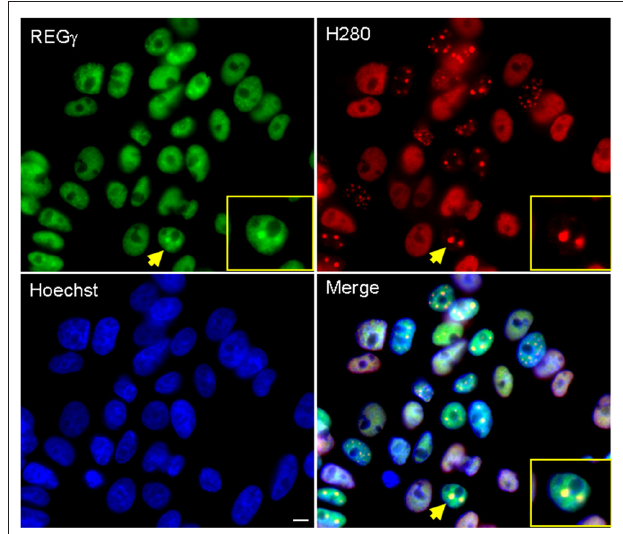
FIGURE 1 | REG γ colocalizes with ARQ112 in inclusion bodies in PC12 cells. Immunofluorescence of PC12 ARQ112 cells induced with doxycycline (Dox) and treated with dihydrotestosterone (DHT) for 48 h. Cells were stained with androgen receptor (AR; H280) and REG γ antibodies. Hoechst staining was carried out to detect nuclei. Arrow indicates a cell positive for AR nuclear inclusions that co-localize with REG γ ; this cell is magnified in the inset. Scale bar represents 5 µ